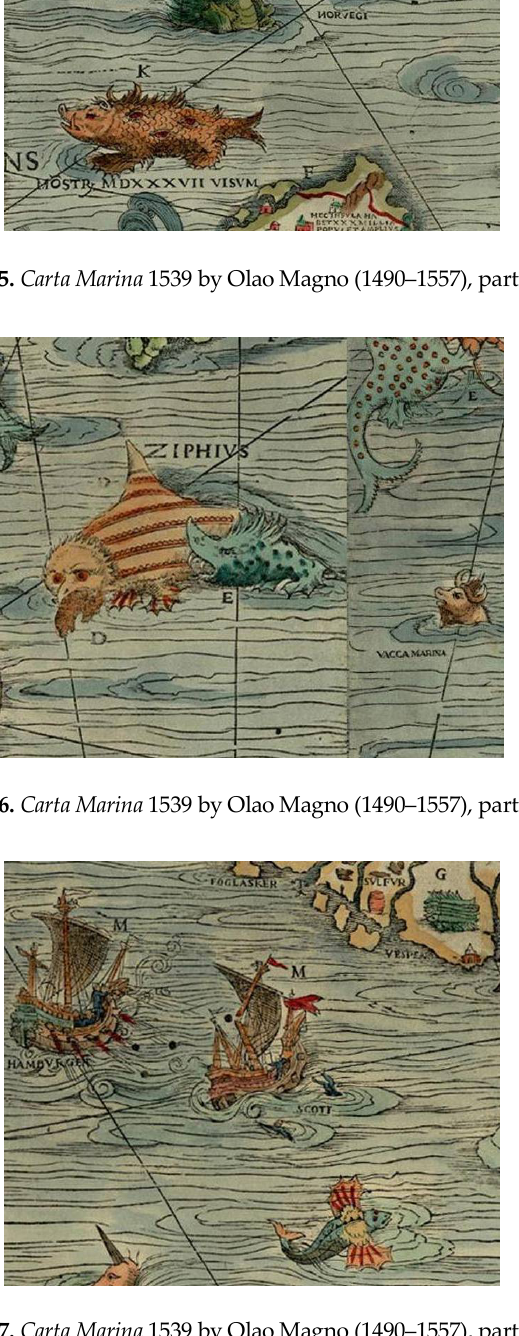
Figure 7. Carta Marina 1539 by Olao Magno (1490–1557),